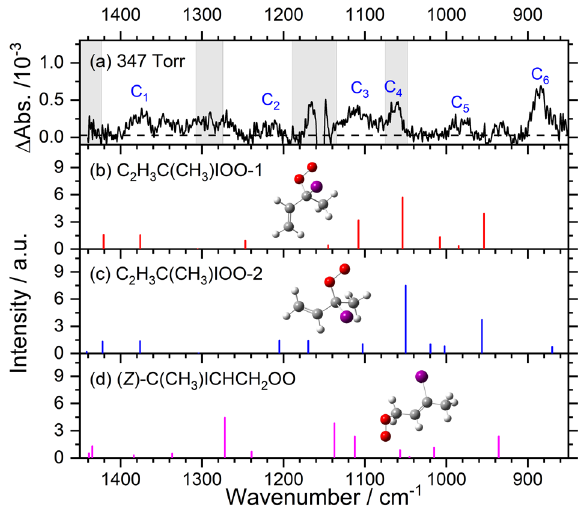
Fig. 4 Comparison of bands in group C with predicted stick spectra of various isomers of iodoperoxy radicals. a Experimental spectrum at 347 Torr, taken from Supplementary Fig. 10(g); bands of group C are labeled. Grey areas represent regions of possible interference from absorption of the precursor. IR stick spectra according to scaled harmonic vibrational wavenumbers and IR intensities predicted with the B3LYP/aug-cc-pVTZ-pp method are shown for two least-energy conformers of C 2 H 3 C(CH 3 )OO ( b , c ) and the least-energy conformer ( Z )-C(CH 3 )ICHCH 2 OO ( d